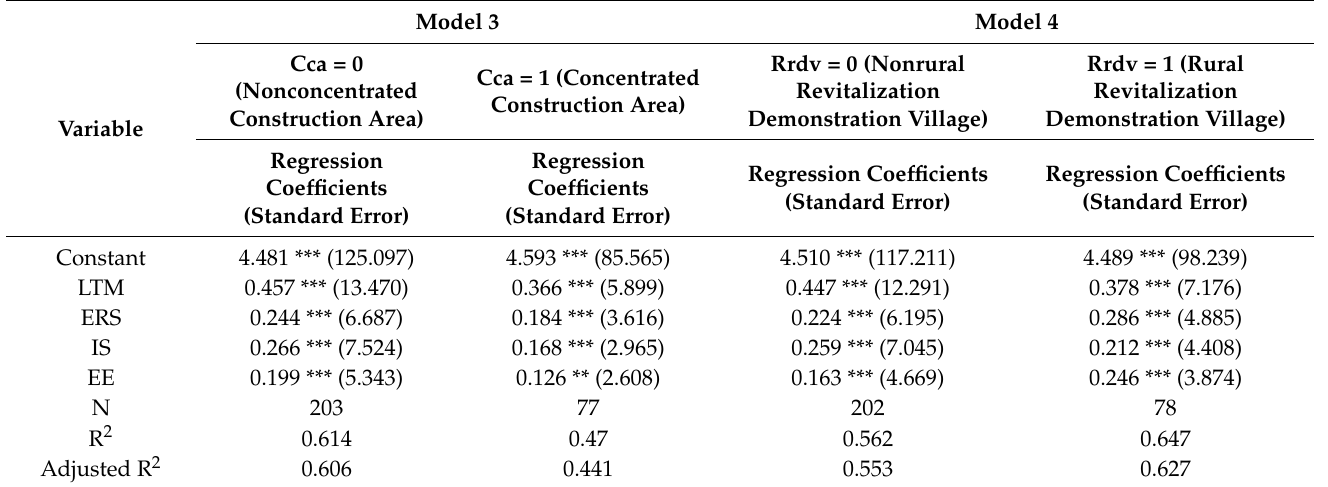
Table 6. Robustness test results.